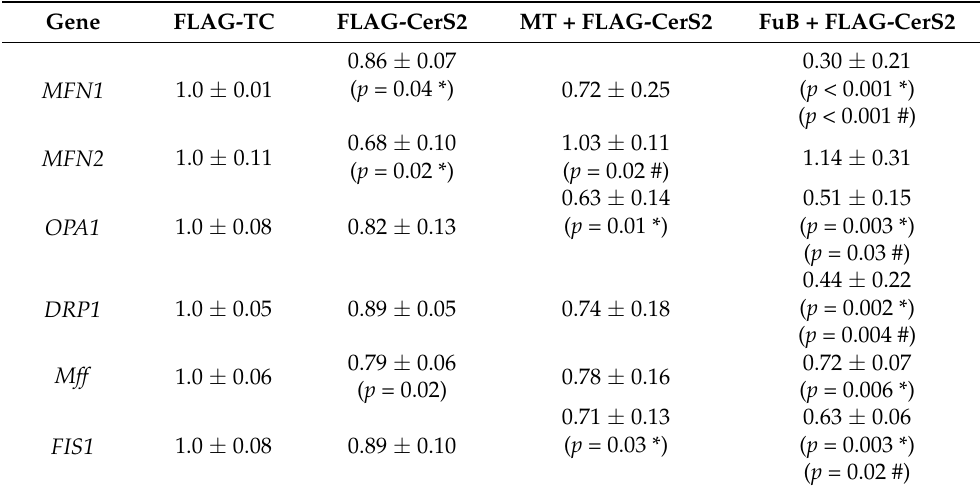
Table 7. Mitochondria fusion and fission related mRNA expression in transfected Fibroblasts.